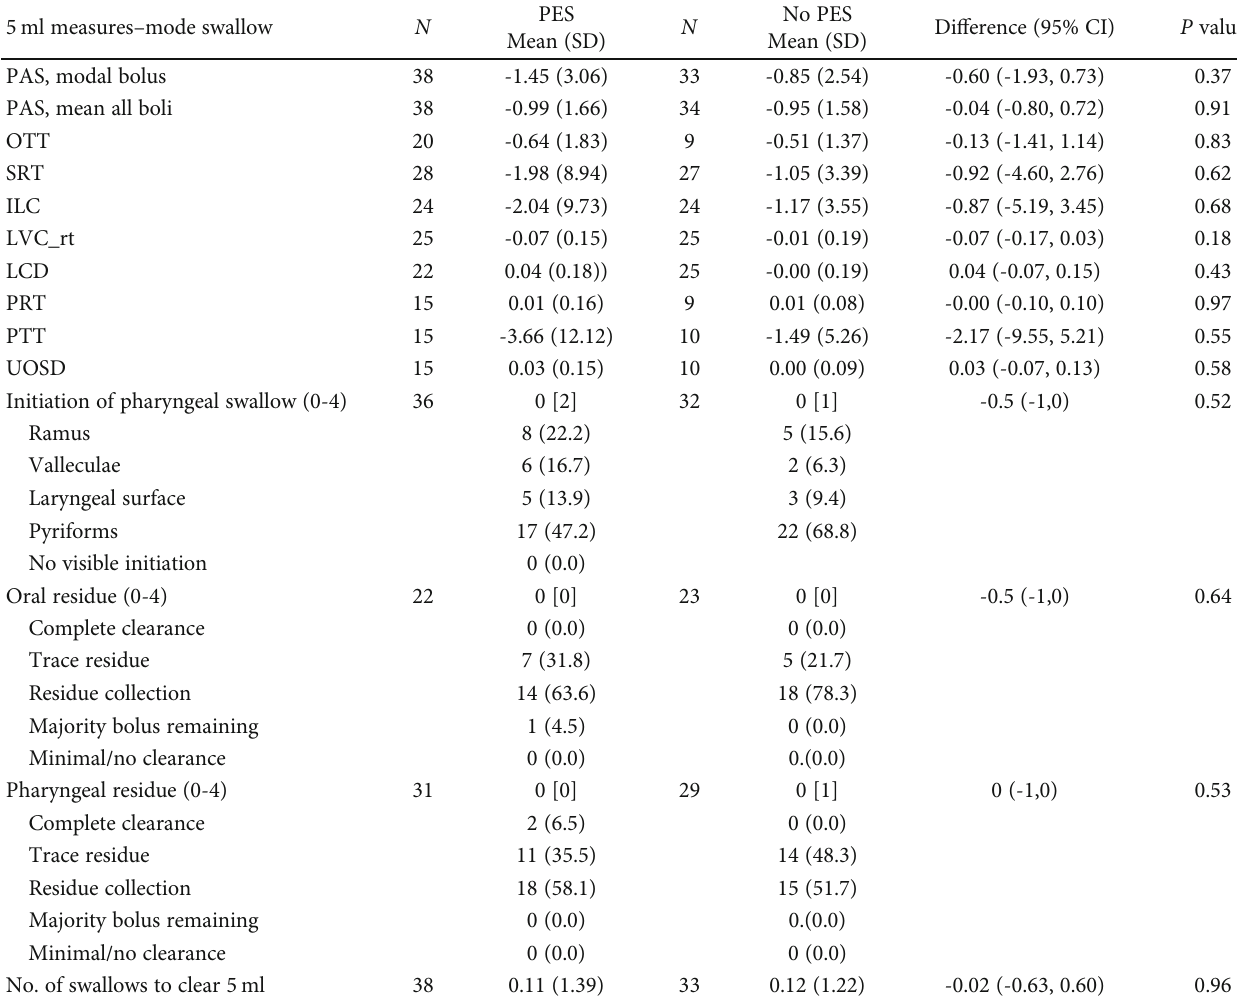
Table 3: Comparison of PAS, timing, and clearance measures for 5ml mode swallow, by change score from baseline to two weeks, using Independent Samples T -Test (continuous variables) and Mann – Whitney U Test (ordinal